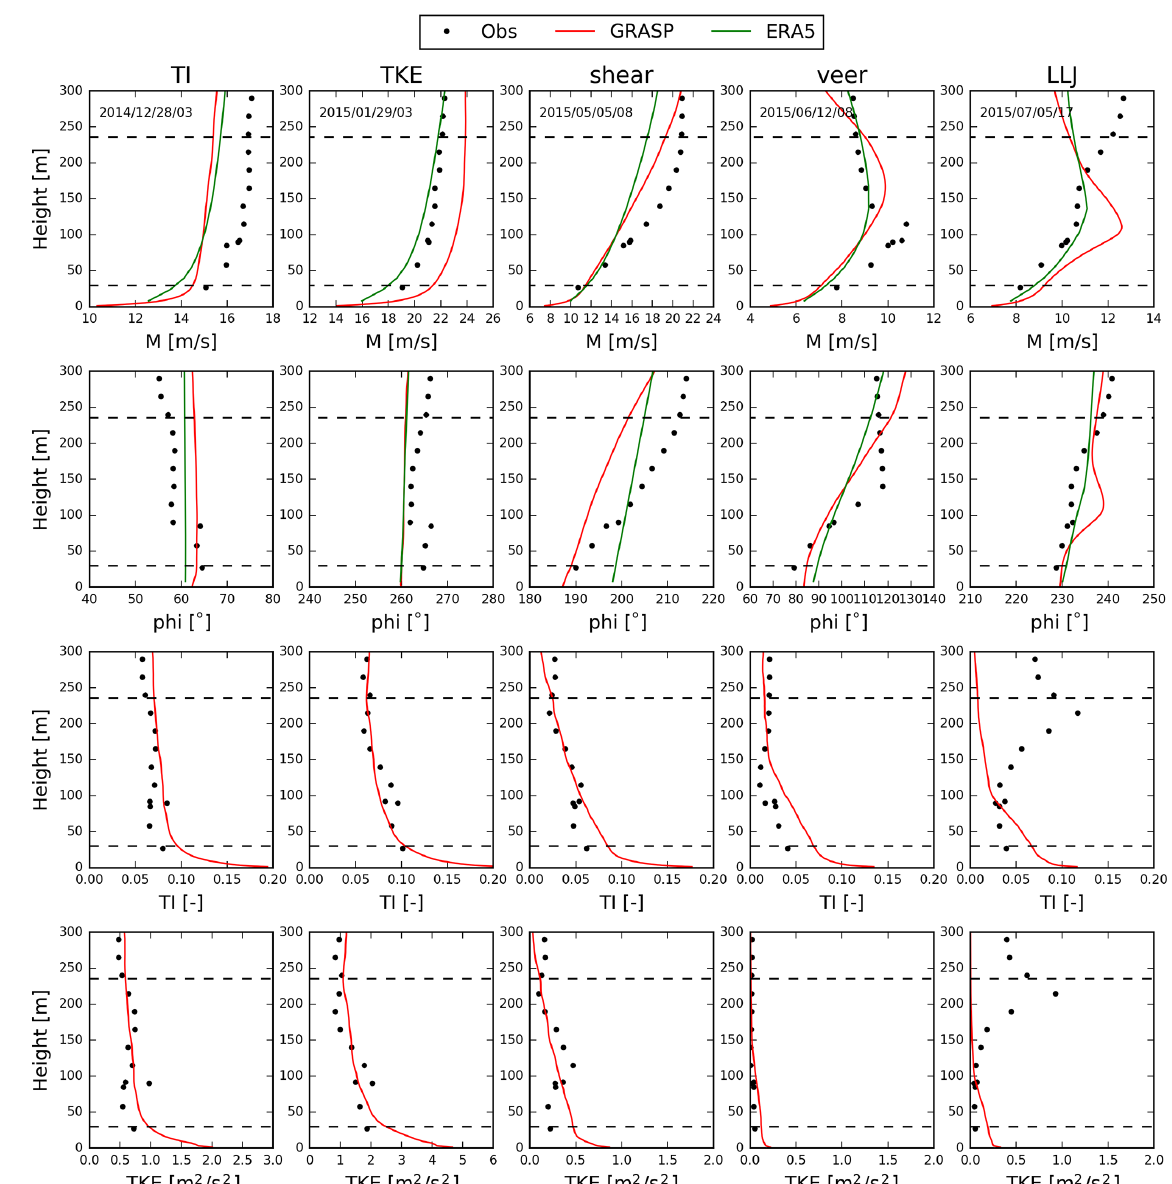
Figure 5. Profiles of four meteorological quantities (wind speed U , wind direction φ , turbulence intensity TI and turbulent kinetic energy TKE) for the five selected extreme cases (different columns) with high TI, TKE, wind shear, veering and a strong LLJ. Observations are indicated as black dots, the high-resolution GRASP (2m grid-spacing) results in red and ERA5 reanalysis data in green. Dashed lines indicate the upper and lower parts of the rotor